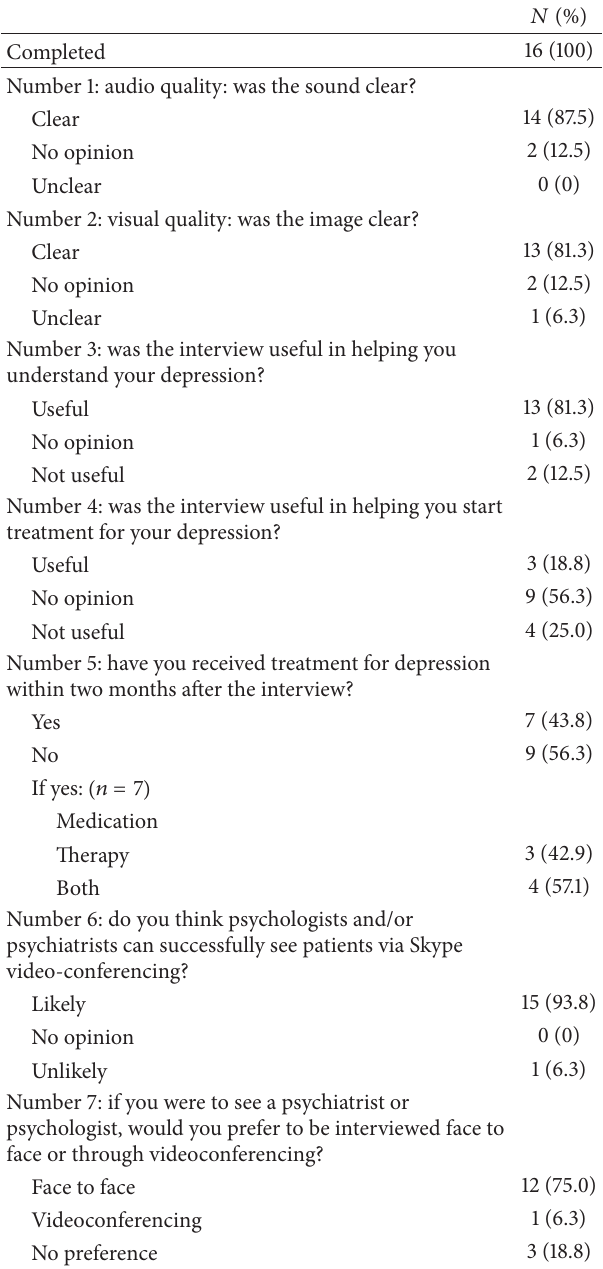
Table 2: Descriptive statistics of Skype satisfaction